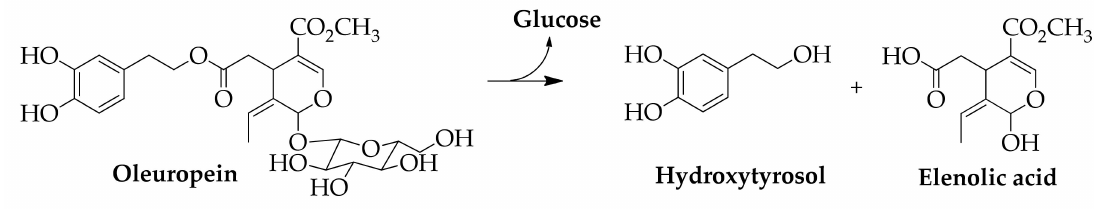
Figure 8. From oleuropein to